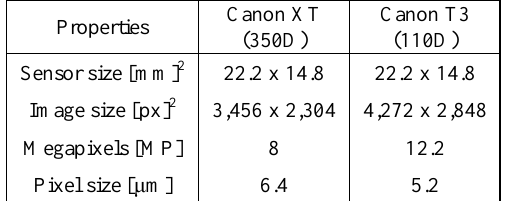
Table 1. Properties of the camera bodies used in this research